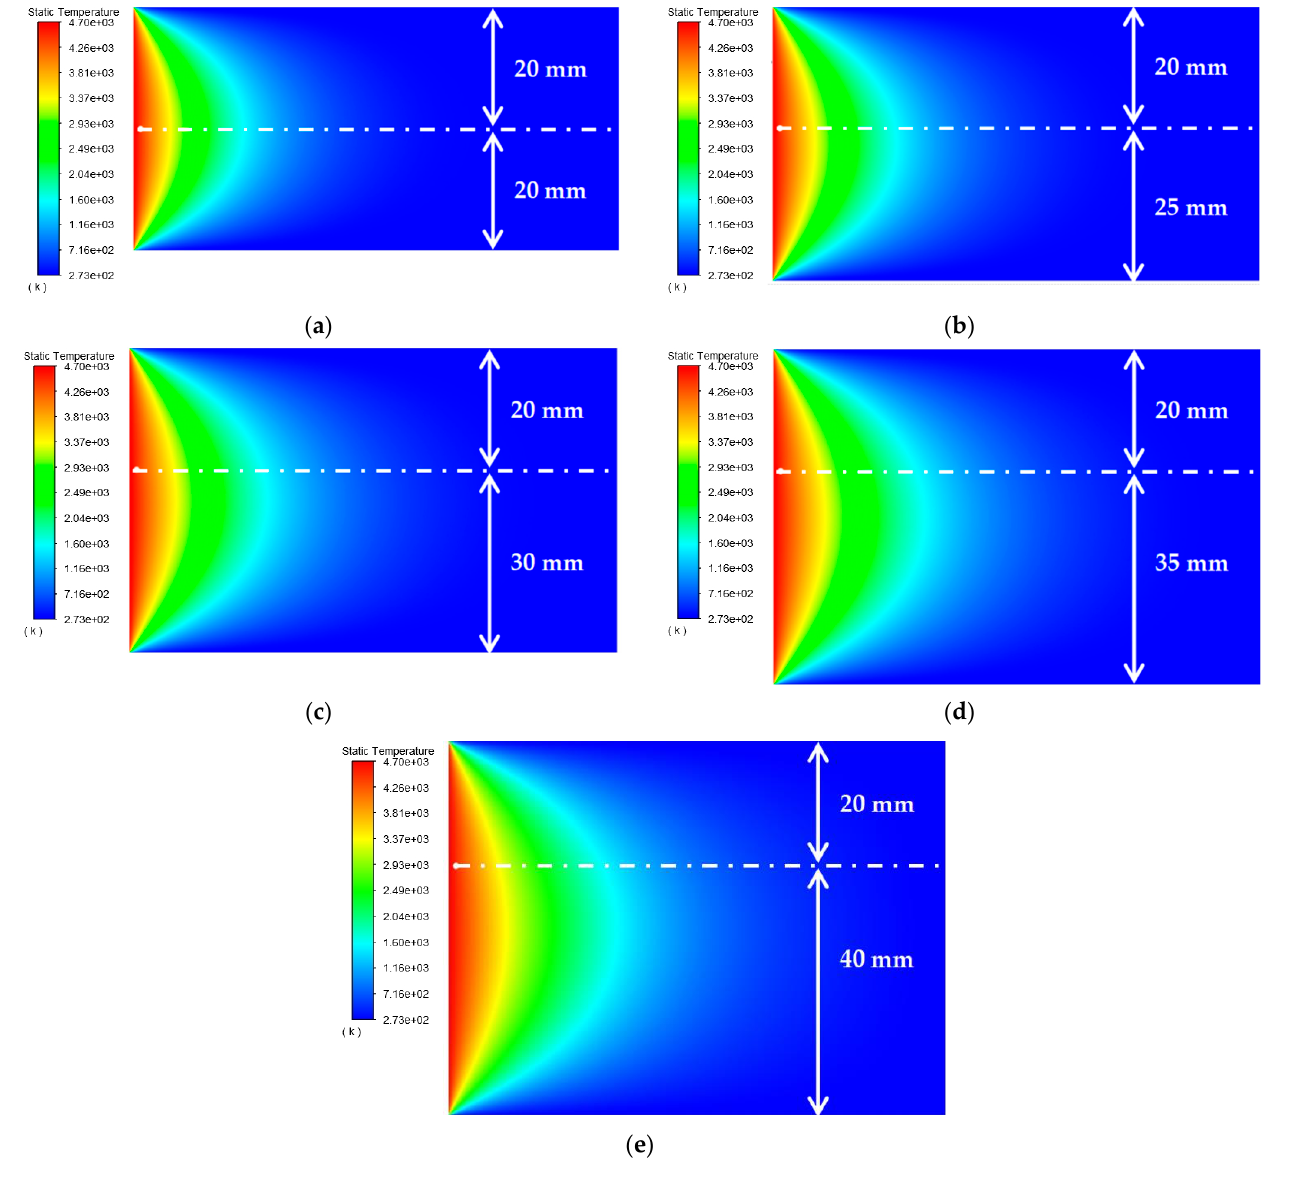
Table 4. Parameters of circular hole and incident light source in the third